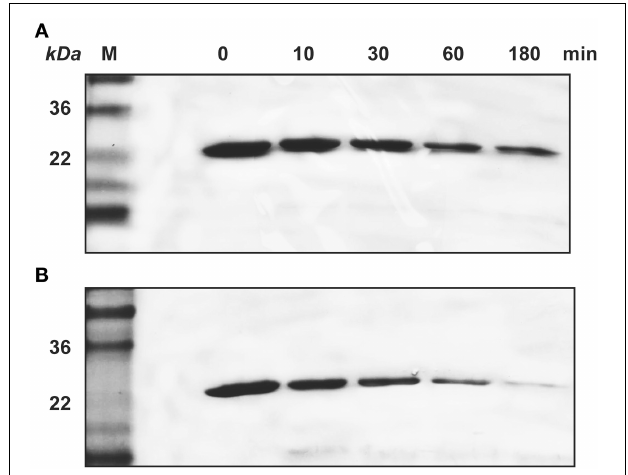
FIGURE 4 | KLK4 digestion of amelogenin in solution and on HAP shown by SDS-PAGE. (A) Amelogenin digestion in solution. (B) KLK4 hydrolysis of amelogenin adsorbed on HAP. M, standard molecular